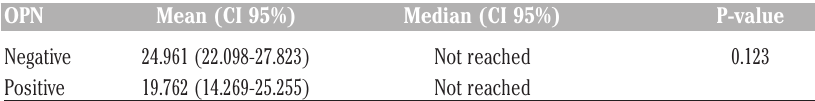
Table 2. Survival comparison between groups with positive and negative OPN expres- sion.